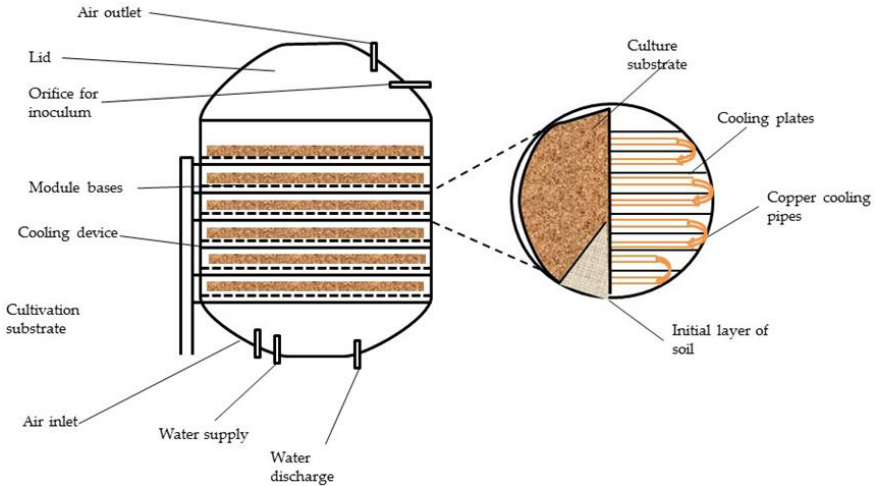
Figure 2. Schematic of solid state fermenter for conversion of lignocellulosic biomass to enzymes.